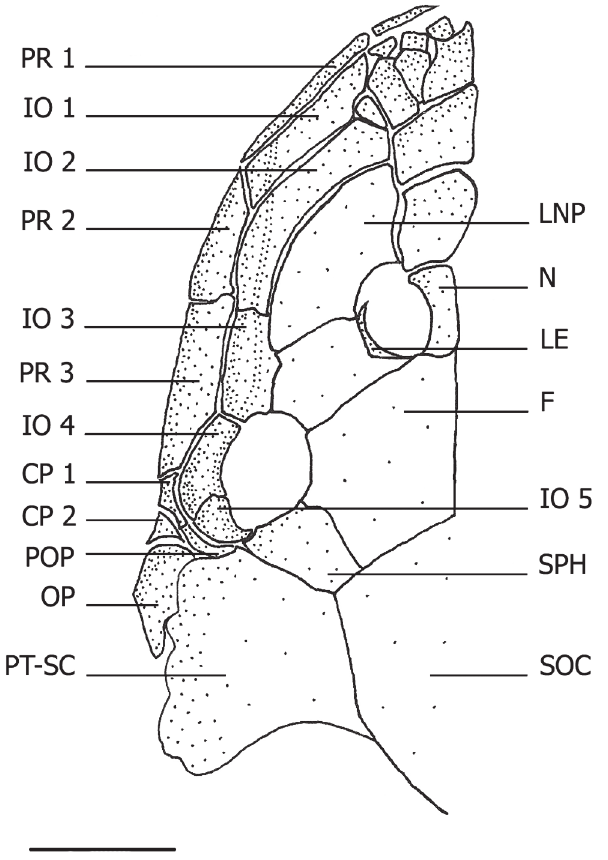
Fig. 2. Skull of Rhinolekos schaeferi (left side, dorsal view), paratype, DZSJRP 12192, 36.5 mm SL. Scale bar = 1 mm. CP1- 2 = cheek plates; F = frontal; IO1-5 = infraorbitals 1-5; LE = lateral ethmoid; LNP = lateronasal plate; N = nasal; NP = nuchal plate; OP = opercle; PF = prefontral plate; POP = preopercle; PR1-3 = postrostrals plates 1-3; PT-SC = compound pterotic; SOC = supraoccipital; SPH =